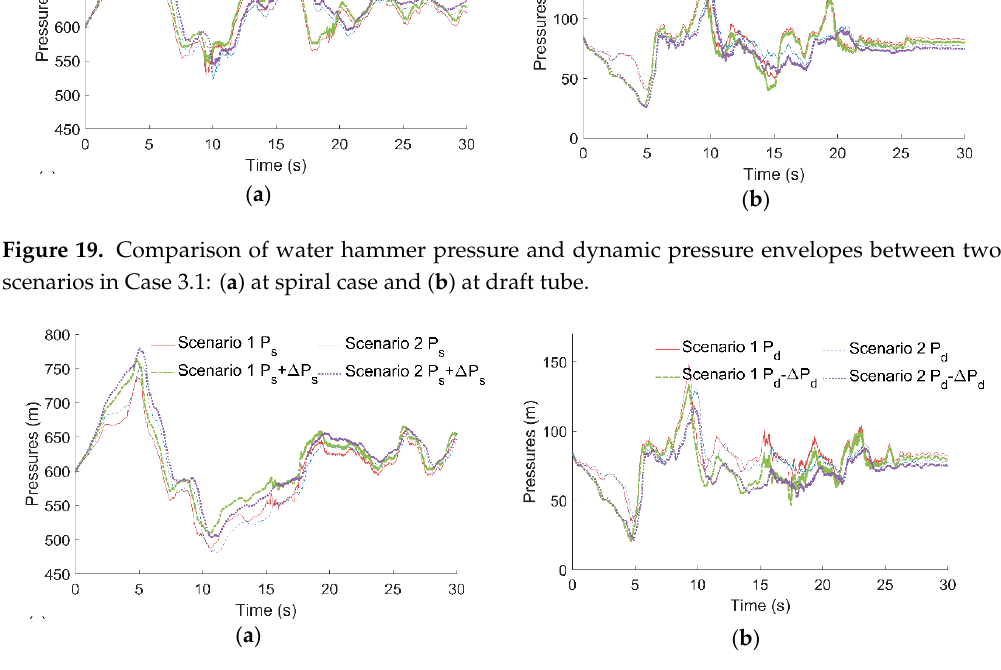
Figure 20. Comparison of water hammer pressure and dynamic pressure envelopes between two scenarios in Case 3.2: ( a ) at spiral case and ( b ) at draft tube.